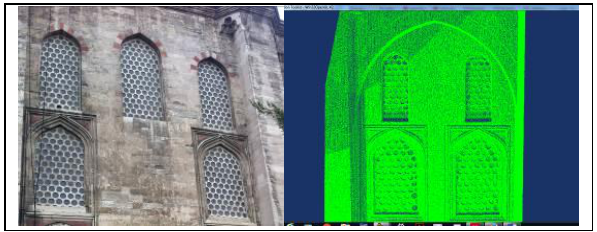
Figure 2. A part exemplary façade with different window design elements seen in the image and relevant point cloud.